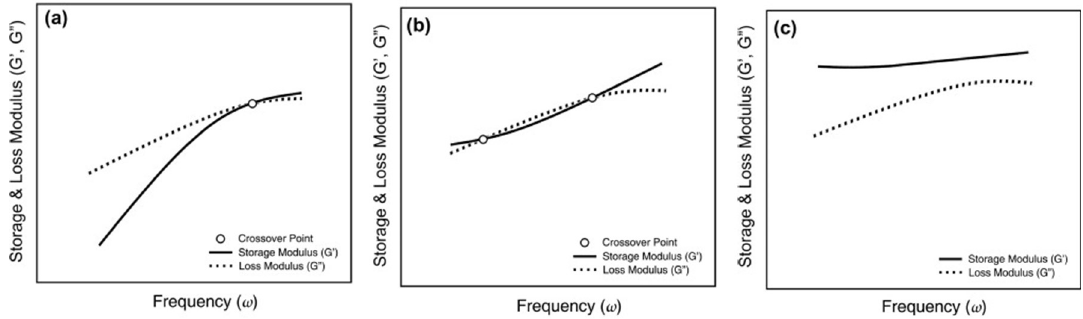
Figure 2. Typical storage and loss moduli of polymer/carbon nanotube (CNT) composites with different amounts of CNTs, as a function of frequency: ( a ) pure polymer, ( b ) with low CNT content and ( c ) with high CNT content. Reprinted with permission from [56]. Copyright (2014) Elsevier.